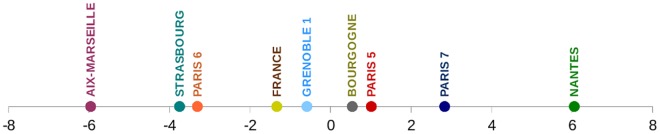
Overall Interdisciplinarity index for 8 French universities.Indexes are centred on the world indexes and multiplied by 100.